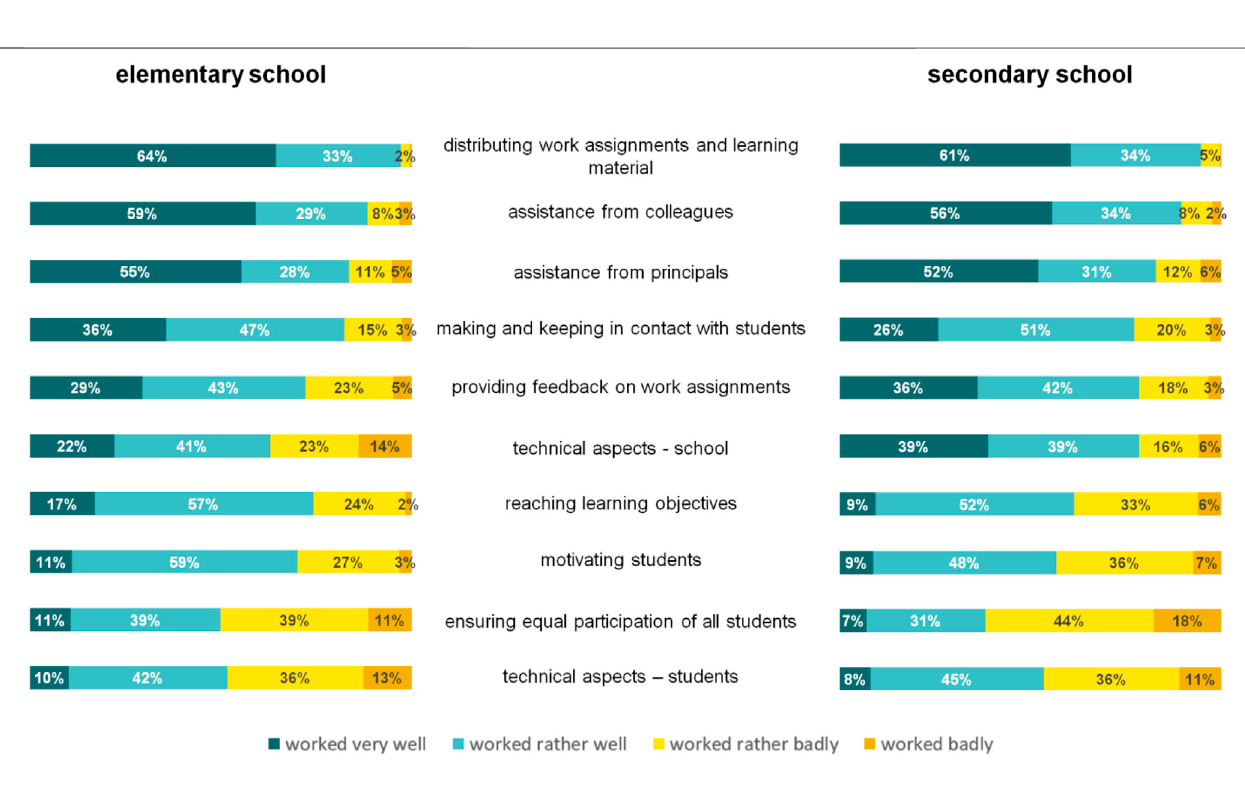
FIGURE 7 | Evaluation of different aspects of distance